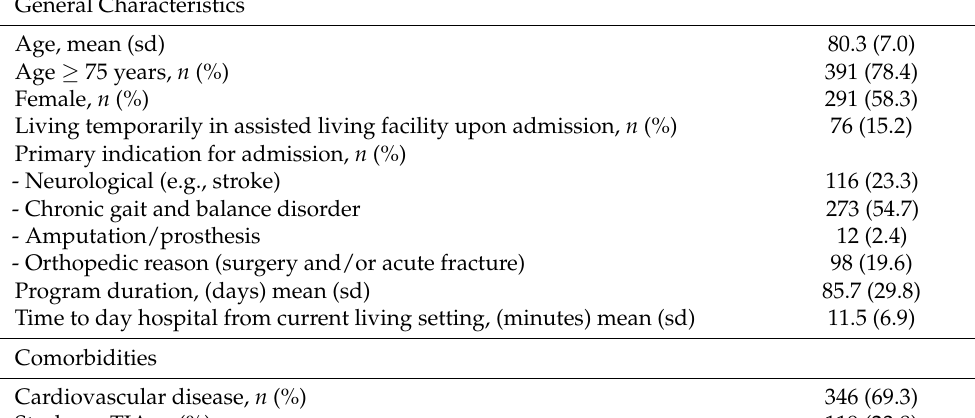
Table 1. Clinical characteristics of patients attending the program of the geriatric day hospital ( n =